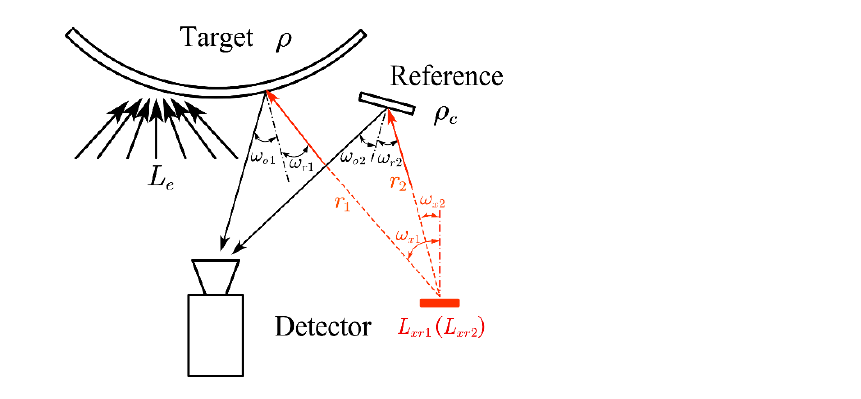
Figure 8. Schematic diagram of a measurement scene irradiated by a small-surface source. Change the radiance of the small-surface source to L xr 2 , the radiance received by the detector from that same point